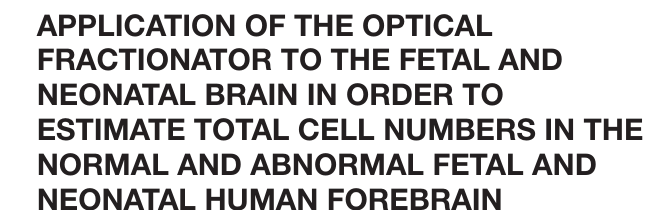
FIGURE 2 | (A) The inclusion line (green line) for the CP/MZ is drawn according to the outer pial surface, whereas the exclusion line (red line) for the CP/MZ is made at the interface between the CP/MZ and the SP. (B) After the cells in the CP/MZ are counted within optical disectors for this zone, the former exclusion line of the CP/MZ becomes the inclusion line for the underlying SP and a new exclusion line is drawn at the interface between the SP and the IZ. (C,D) The same procedure is applied to the IZ and the SVZ/VZ, thus ensuring that no areas (and thus no cells) are omitted or counted twice due to inconsistent